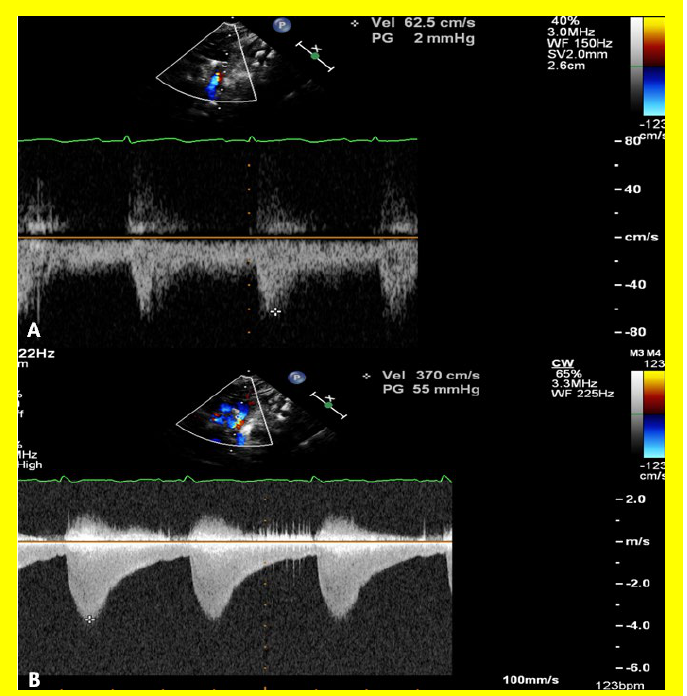
Figure 32. ( A ) Suprasternal notch view of the aortic arch (Arch) in a patient with aortic coarctation (arrow) in 2D ( A ) and color flow mapping ( B ), demonstrating turbulence at the site of coarctation (arrow). AAo, ascending aorta; BCV, brachiocephalic vessels; DAo, descending aorta. Reproduced from Reference [53].